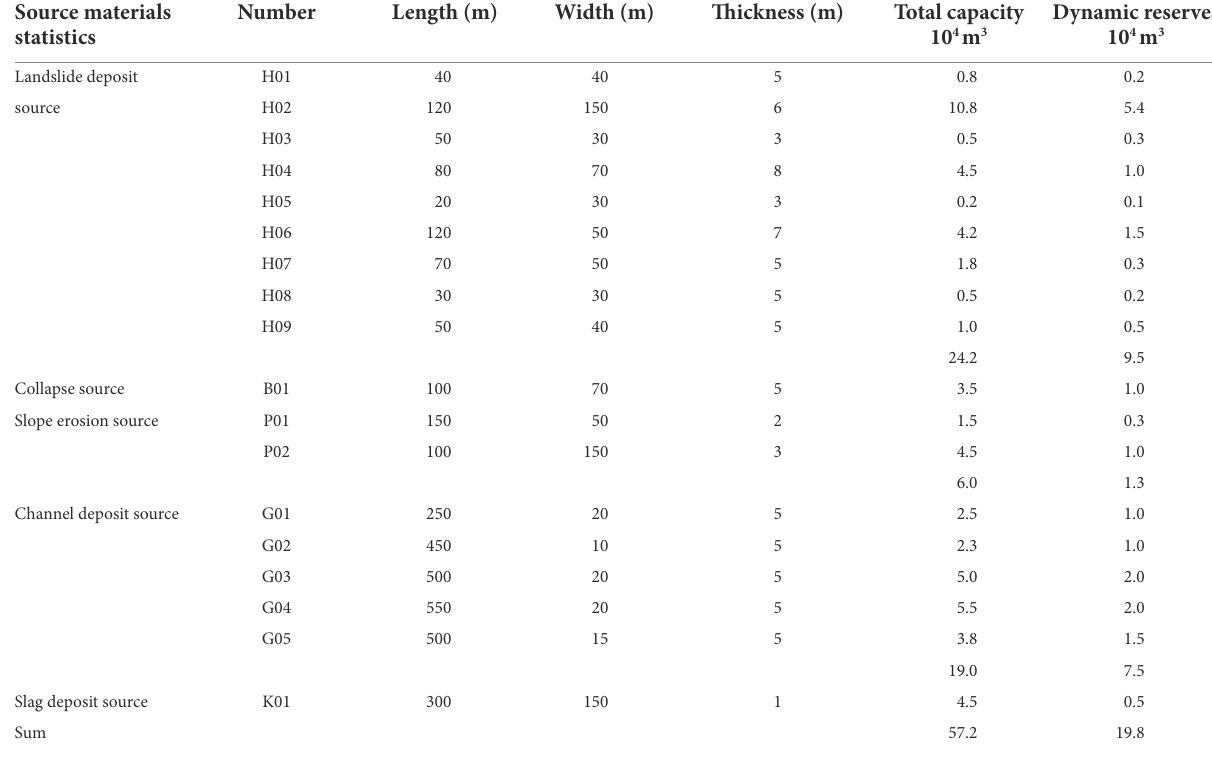
TABLE 4 Loose solid materials statistics in Legugou source